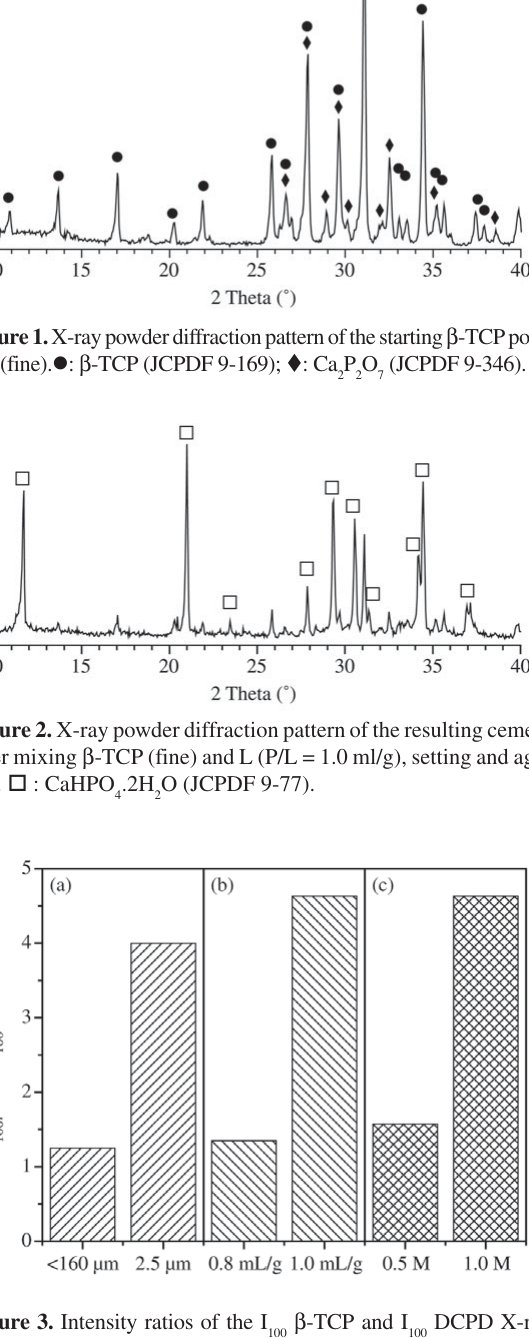
β -TCP and I Figure 3. Intensity ratios of the I DCPD X-ray 100 100 diffraction peaks for cements hydrolysed at 60 °C for 16 h. (a) pre- pared with coarse and fine β -TCP, L/P = 1.0 ml/g, and hydrolysed in 1.0 M Na HPO ; (b) prepared with fine β -TCP, L/P of 0.8 and 2 4 1.0 ml/g, and hydrolysed in 1.0 M Na HPO ; (c) prepared with fine 2 4 β -TCP, L/P = 1.0 ml/g, and hydrolysed in 0.5 and 1.0 M Na HPO . 2 4